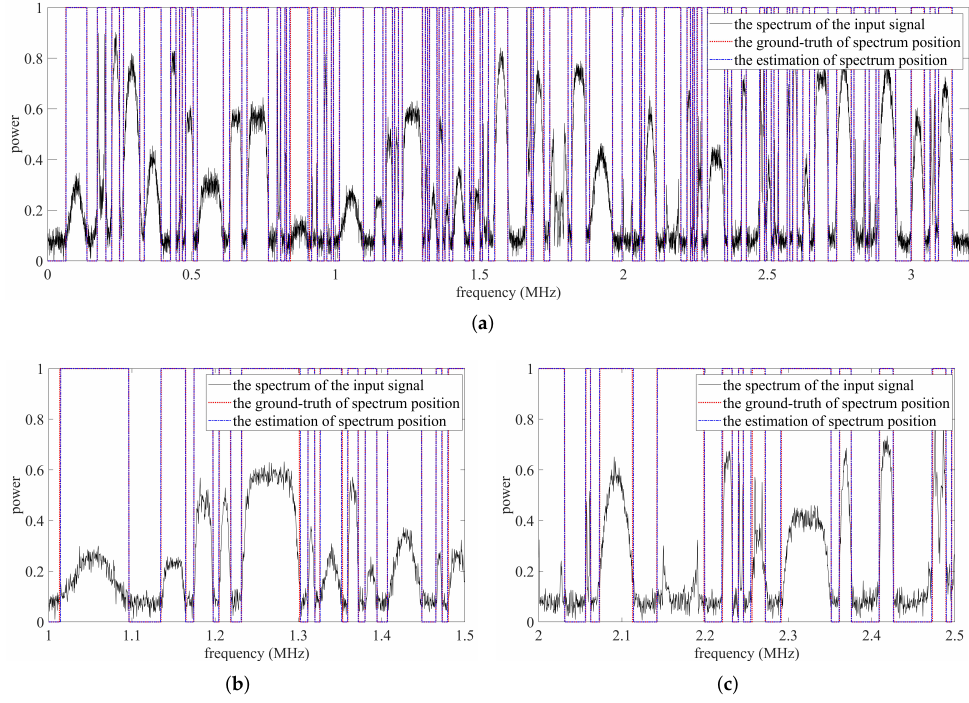
Figure 13. Predicted results for the first example. ( a ) The whole band of the first prediction example. ( b ) The sub-band_1 of the first prediction example. ( c ) The sub-band_2 of the first prediction